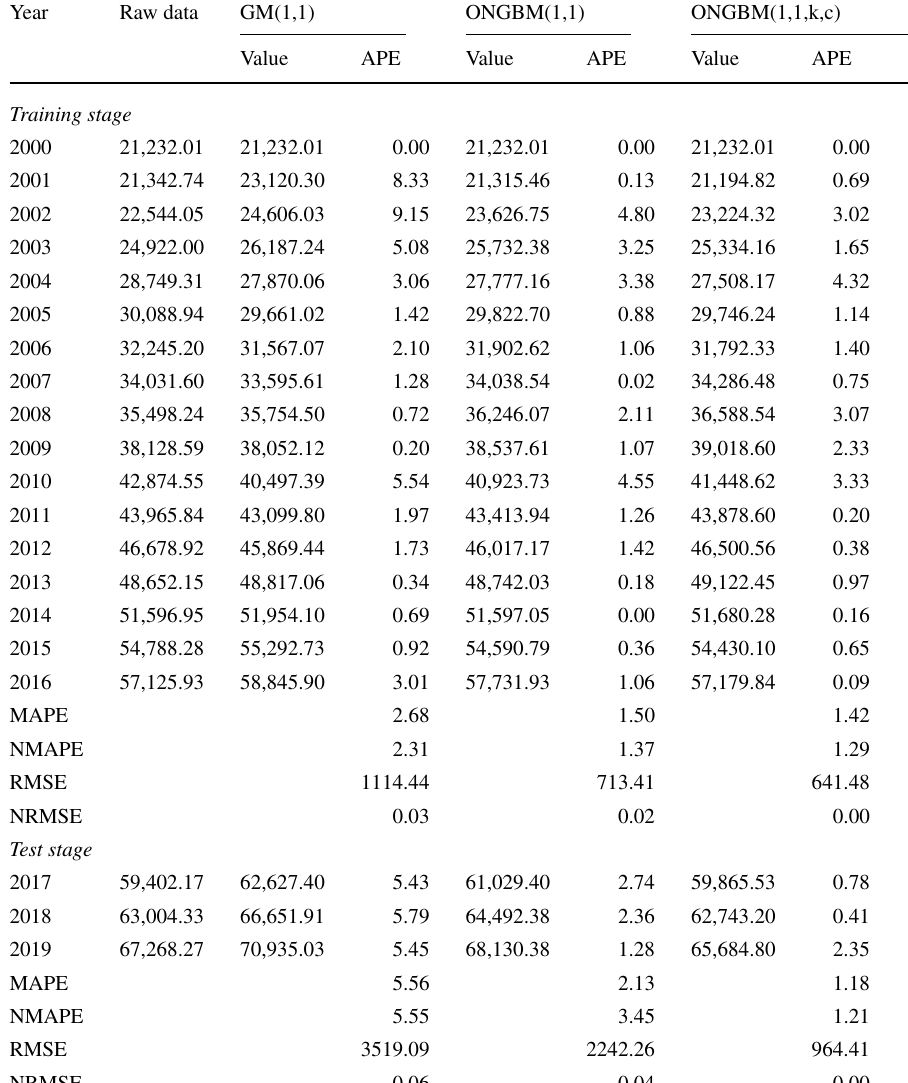
Table 2 Fitted and predicted values and errors (%) by the different grey models in China’s coal